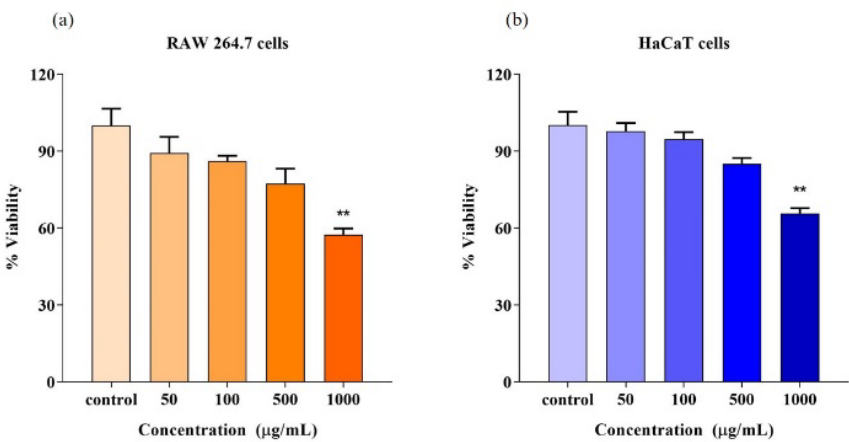
Figure 8. Effect of Virgibacillus dokdonensis VITP14 exopolysaccharide (EPS) on cell viability: ( a ) RAW264.7 cells; ( b ) HaCaT cells. Values are means and error bars indicate standard deviations ( n = 3). The results p < 0.05 (*), p < 0.01 (**) were considered as significant in comparison to